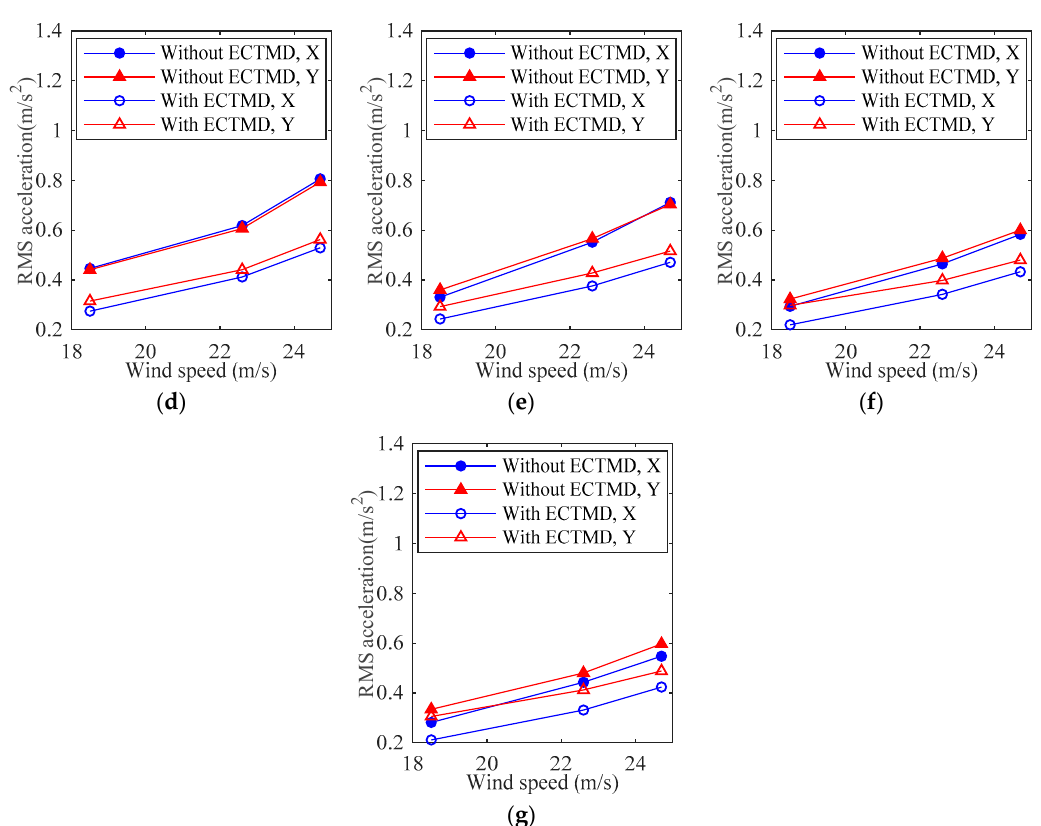
Figure 18. Variation of RMS acceleration with wind speed and wind direction. ( a ) 0°; ( b ) 15°; ( c ) 30°; ( d ) 45°; ( e ) 60°; ( g ) 90°.